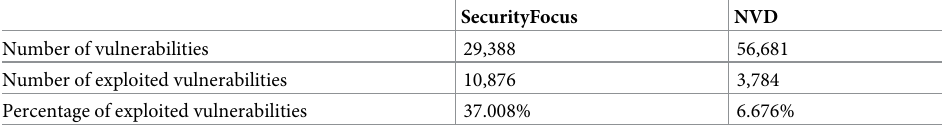
Table 1. Number of vulnerabilities, number of exploited vulnerabilities, the fraction of exploited vulnerabilities that appeared in each source.